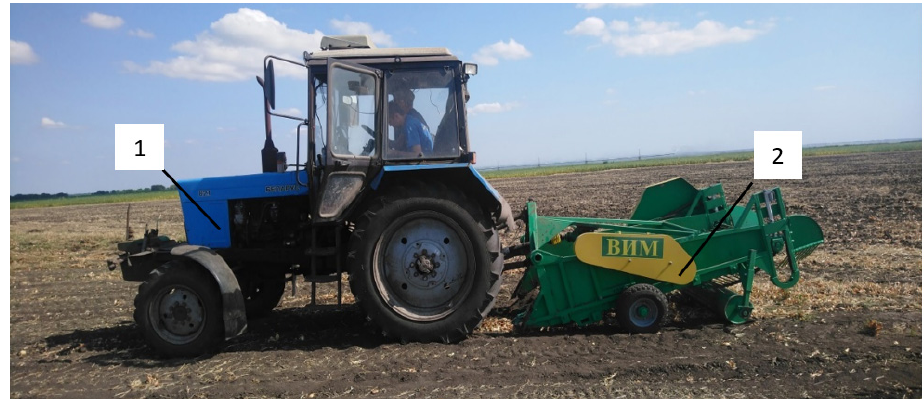
Figure 6. General view of the harvesting unit for harvesting root crops and onions, equipped with a separating rod elevator with an adjustable blade inclination angle: 1—MTZ 1221 tractor; and 2—machine for harvesting root crops and onions.